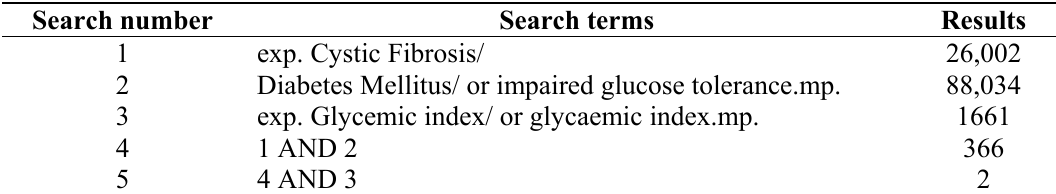
Table 1. Search strategy for Medline (via OvidSP).